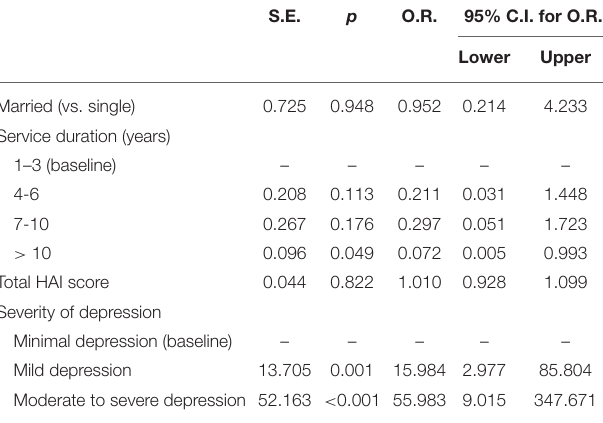
TABLE 2 | Factors associated with current suicidal ideation based on multivariable logistic regression ( N =